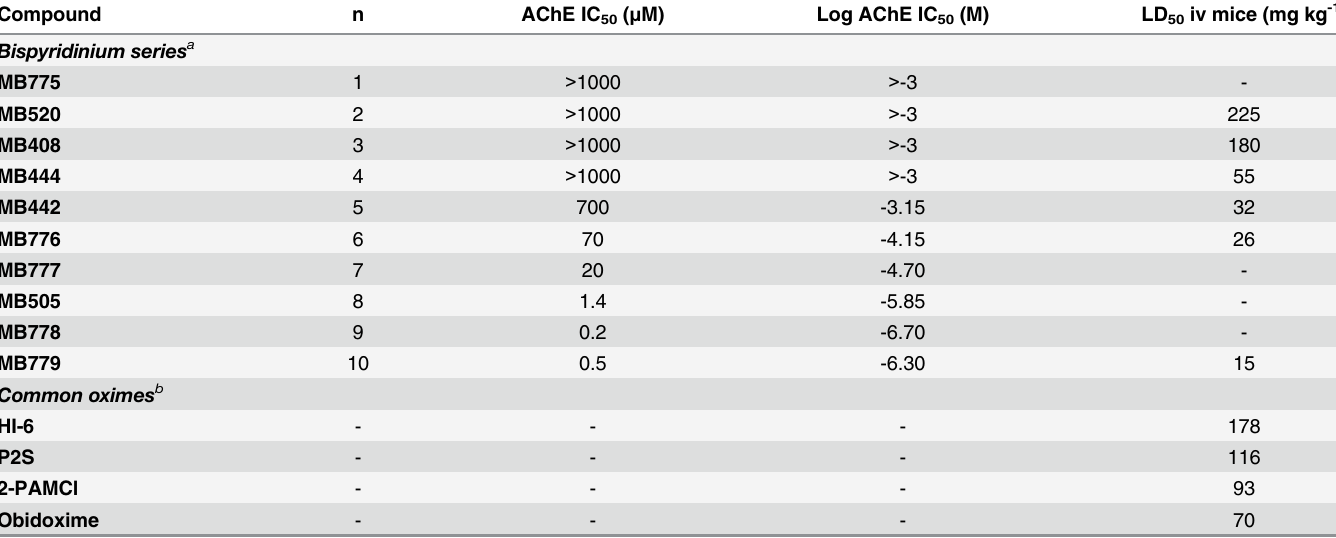
IC 50 values for inactivation of human acetylcholinesterase and intravenous toxicities in mice for the test compounds and some oximes commonly used to treat nerve agent poisoning. a LD 50 data for dibromide salt variants of the MB compounds taken from [24] and [25]. b Averaged LD 50 data from [26].